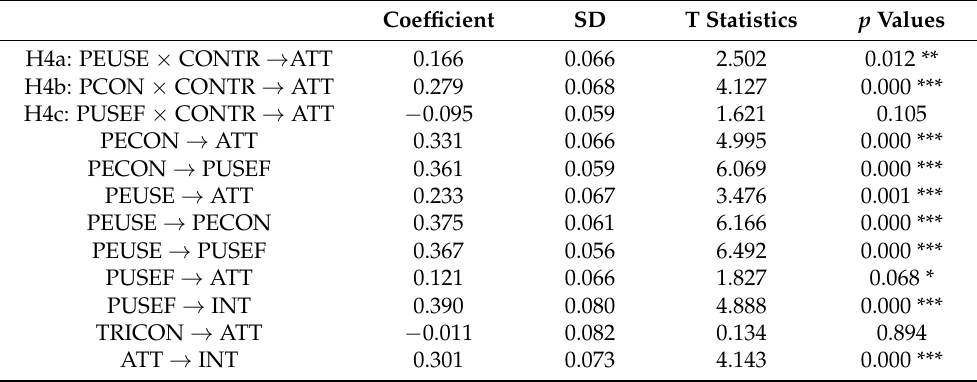
Table 6. Moderating Effect of TRI